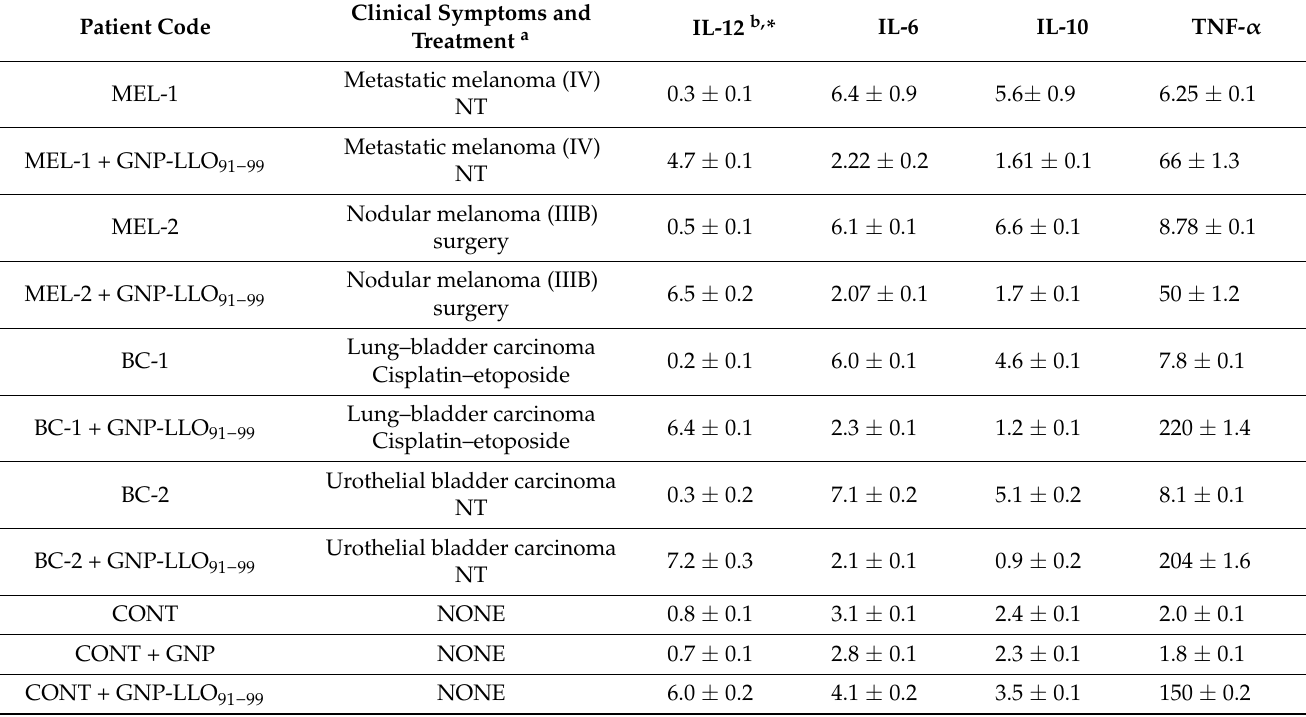
Table 1. Production of cytokines by MoDCs stimulated or not with GNP-LLO 91–99